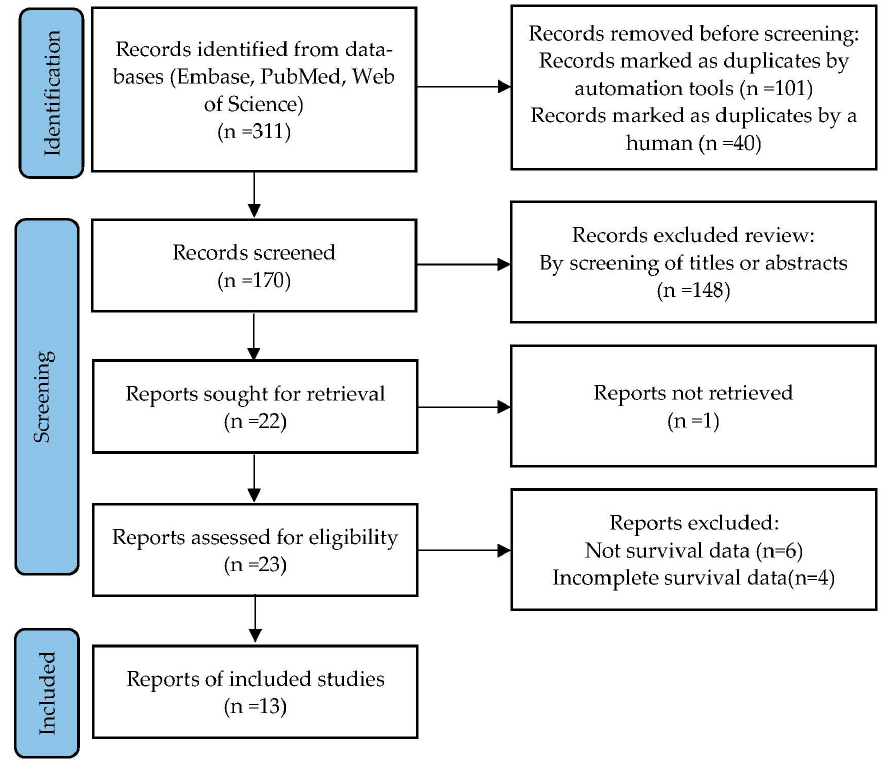
Figure 1. Flow diagram of literature search.